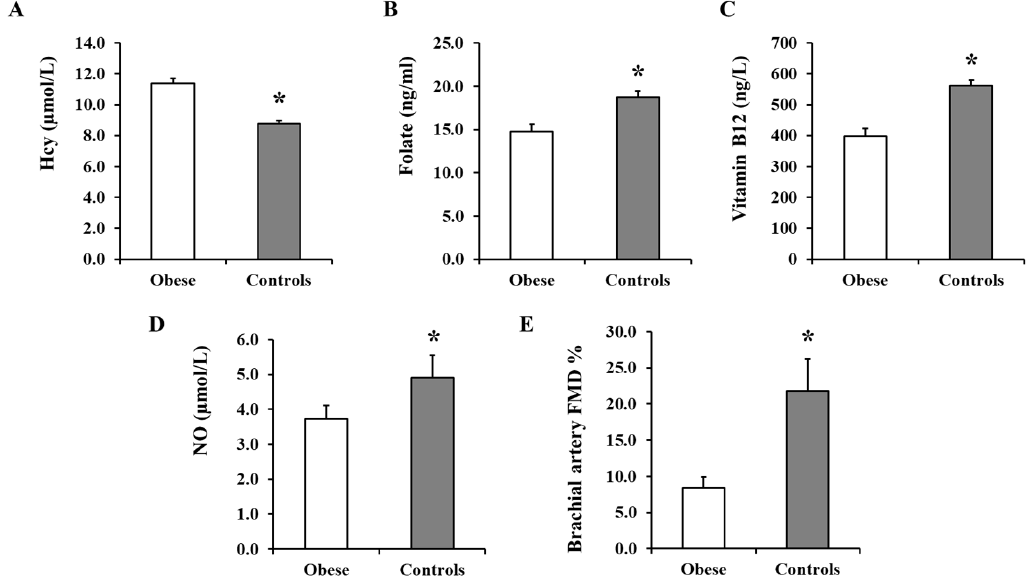
Figure 2. Plasma Hcy, folate, vitamin B12, and NO concentrations and brachial artery FMD measurements. Plasma from obese subjects ( n = 40) and non-obese controls ( n = 40) were analyzed for Hcy ( A ), folate ( B ), and vitamin B12 ( C ) using specific ELISA assays and for nitrates + nitrites (NO metabolites) using the Griess chemical reaction assay ( D ). Percentage of brachial artery FMD was calculated by subtracting the mean baseline diameter from the largest mean values obtained after cuff deflation in obese subjects ( n = 40) and non-obese controls ( n = 40) ( E ). All measurements are presented as means ± standard error (SE). * ( p < 0.05) for comparing obese subjects with controls.